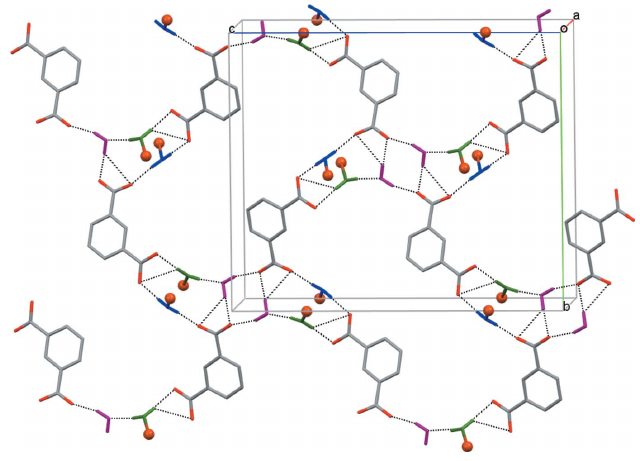
Figure 5 Sheets of isophthalate dianions parallel to the (101) plane in (I). Macrocyclic ligands and H atoms at carbon atoms of the carboxylate anions are omitted, only water molecules coordinated to Cu II (balls) participating in the formation of a carboxylate layer are shown (O1 W – green, O2 W – dark blue, O3 W – violet). Hydrogen bonds are shown as dashed lines.